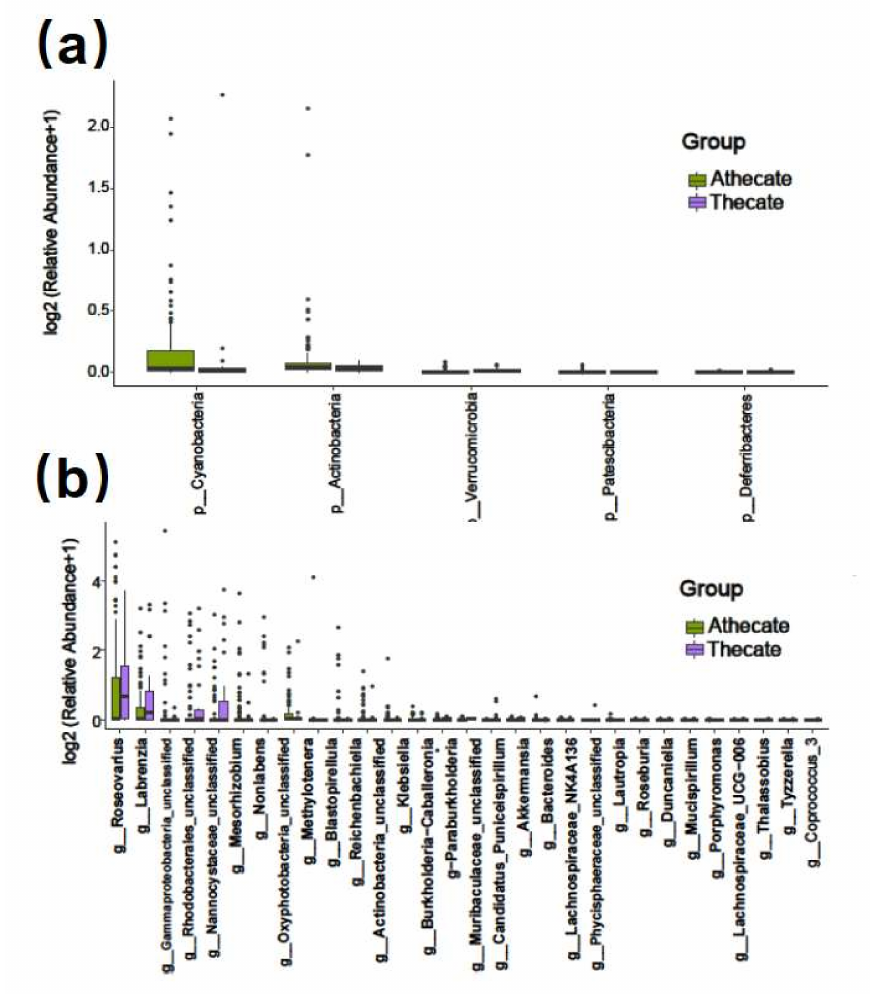
Figure 7. Bar plot of significantly different bacterial phyla ( a ) and classes ( b ) between Thecate and Athecate